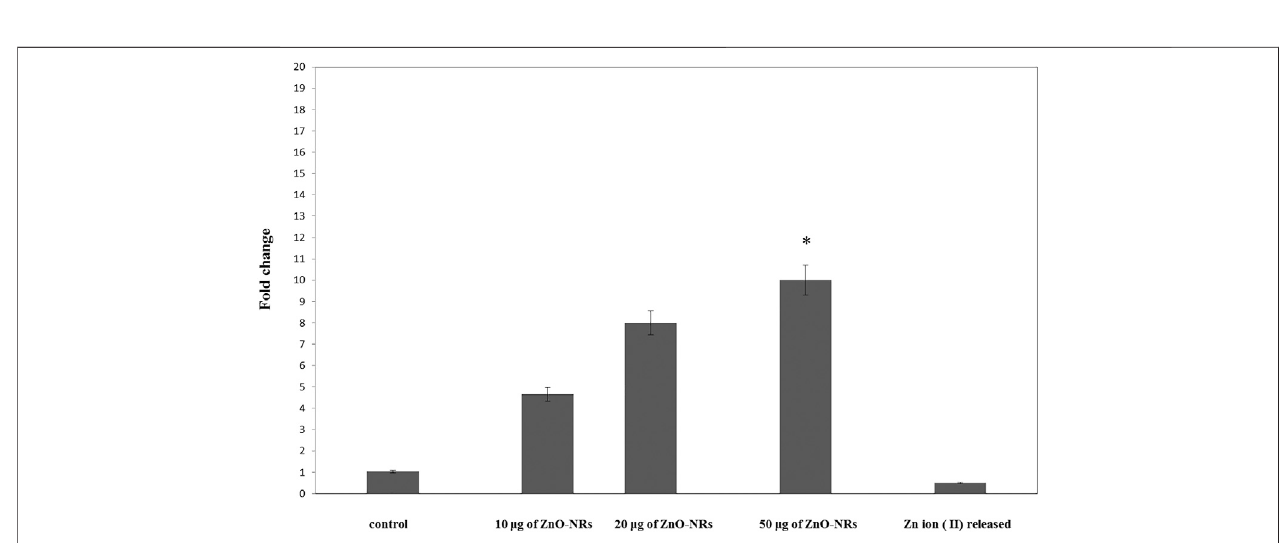
FIGURE 6 | Quantitative real-time PCR measures mRNA levels of the vascular endothelial growth factor gene (VEGF).